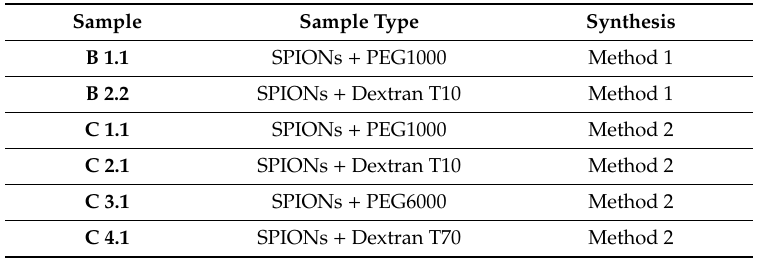
Table 2. Coated SPIONs Samples